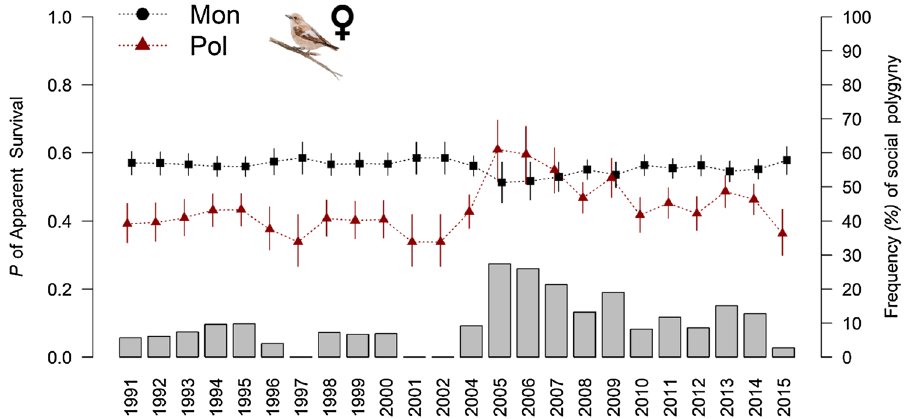
Figure 2. The relationship between local survival probabilities, frequency of social polygyny (FSP), and mating status. 95%CI estimates of female annual local survival according to their mating status (monogamous vs polygamous) and FSP (grey bars) in the previous breeding season. Mon = monogamous, Pol = polygamous (primary or secondary). Only the estimates of > 1-yo females (the effect of age was additive, see Table 1) are shown.